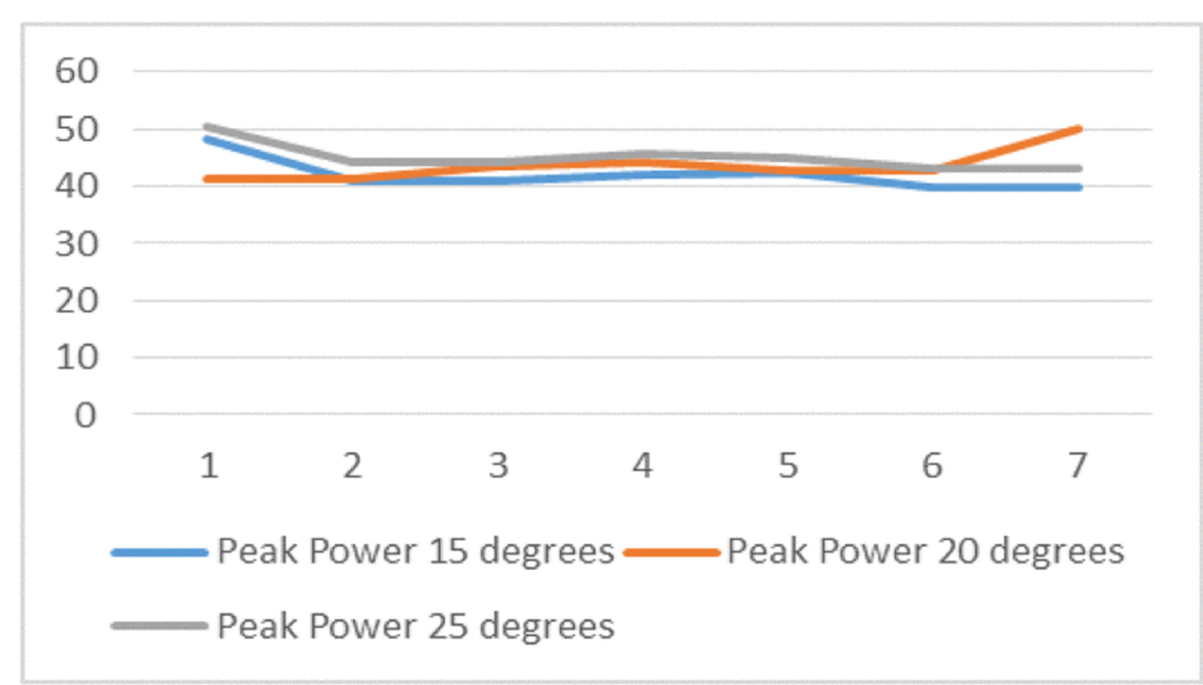
Figure 14. Solar panels installed at different tilt angles [102].